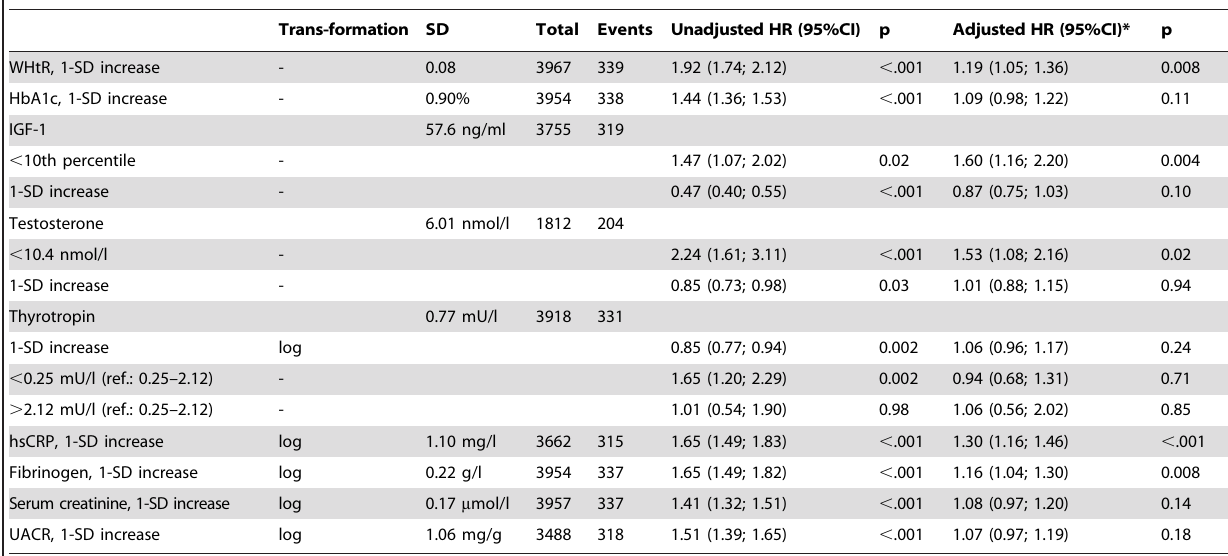
Table 3. Prediction of all-cause death by single biomarkers.